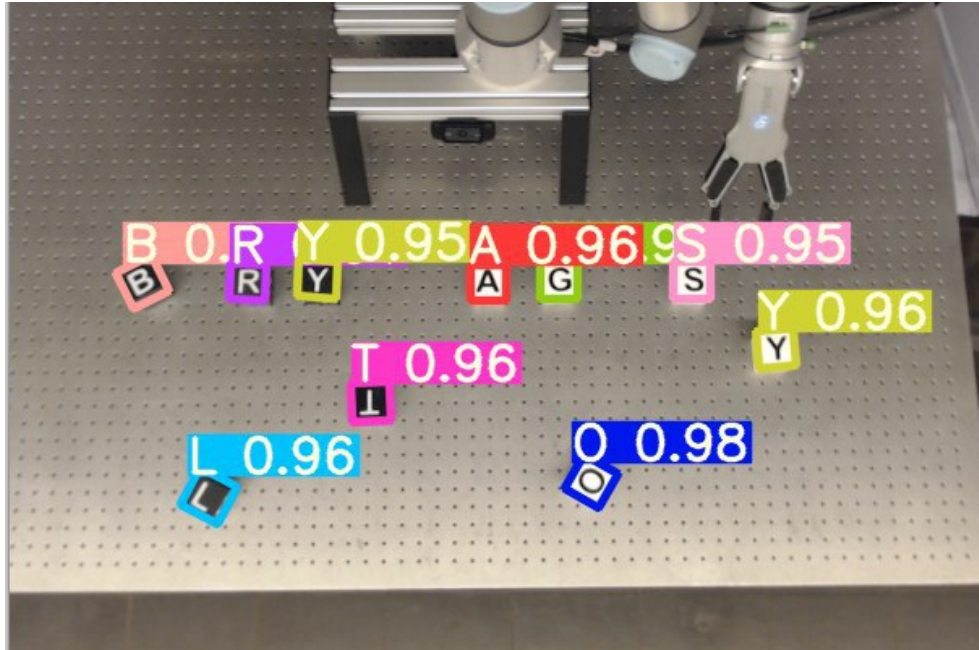
Figure 7. The cube detection in action. It detects also the rotated orientation of the